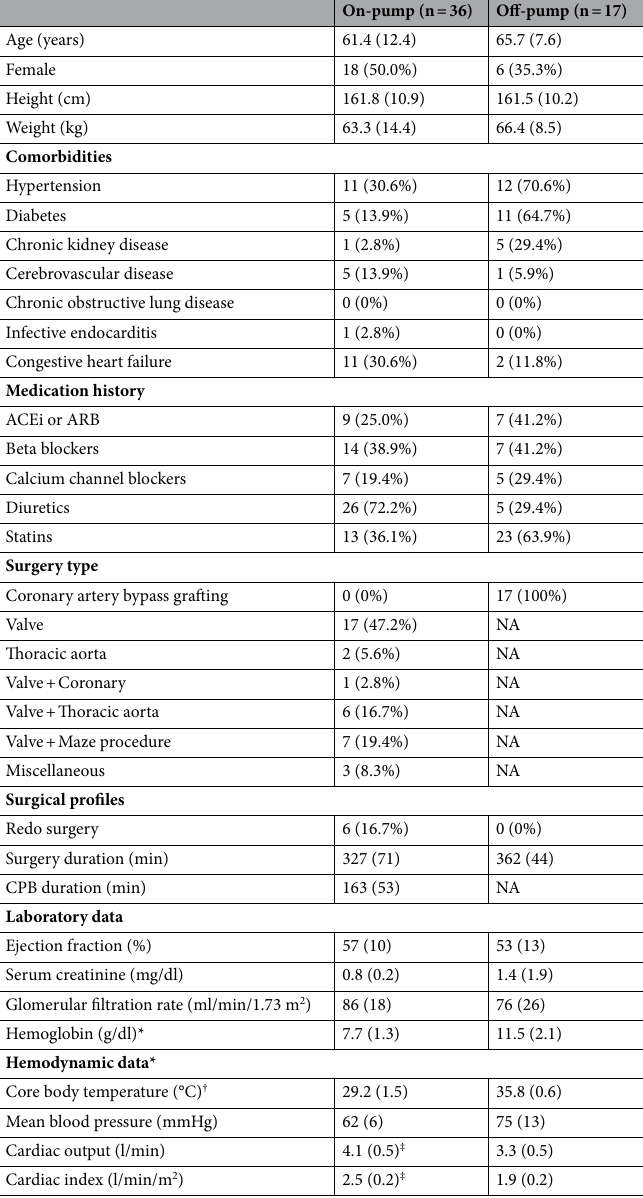
Table 1. Demographics and baseline characteristics of the study population. Data are presented as mean (SD) or number (%). ACEi angiotensin-converting enzyme inhibitors, ARB angiotensin II receptor blockers, CPB cardiopulmonary bypass. *Values measured at T0. † Measured at the nasopharynx. ‡ Based on the pump flow